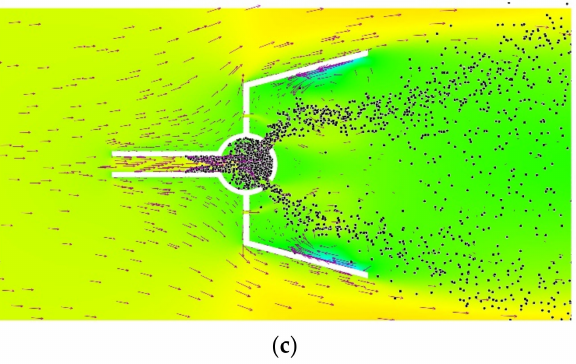
Figure 14. Spray field under different actuation intensities with 5 mm actuation length on inner surface: ( a) 5kV, 14kHz, ( b ) 45kV, 14kHz, ( c ) 85kV, 14kHz.